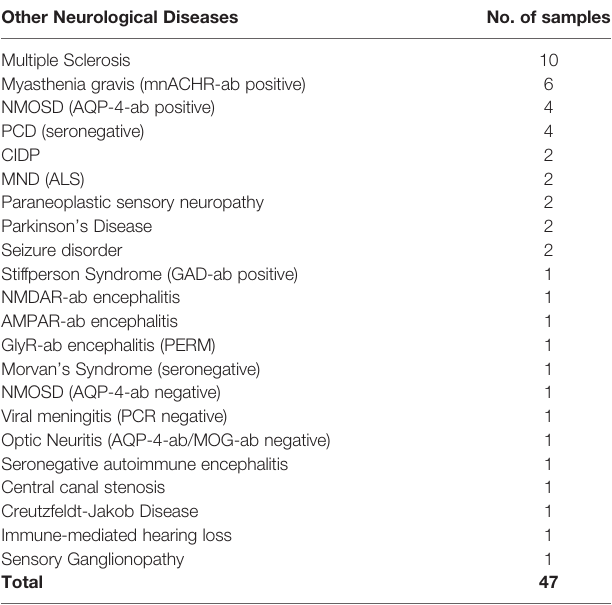
TABLE 3 | Clinical diagnoses of samples from subjects with a range of neurological diagnoses without autonomic dysfunction. Other Neurological Diseases No. of